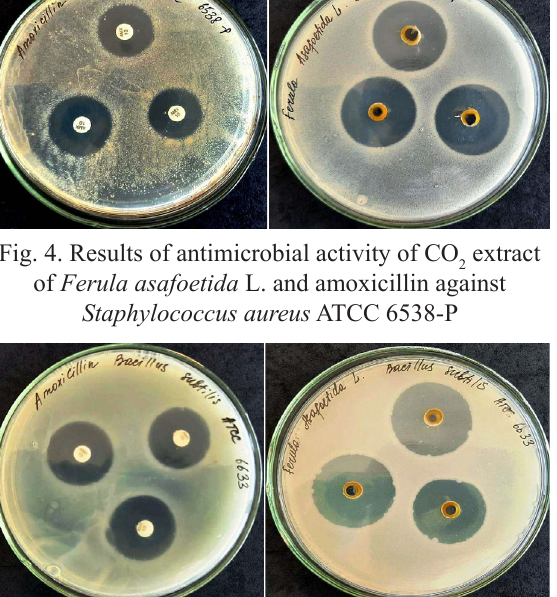
Fig. 5. Results of antimicrobial activity of CO extract of Fig. 9. Results of antimicrobial activity of CO 2 Ferula asafoetida L. and amoxicillin against of Ferula asafoetida L. and fluconazole against Bacillus subtilis ATCC 6633 Results of determination of the antimicrobial activity of CO extract of Ferula asafoetida L . by disk-diffusion method 2 S. aureus B. subtilis Extract АМХ (10 mсg)